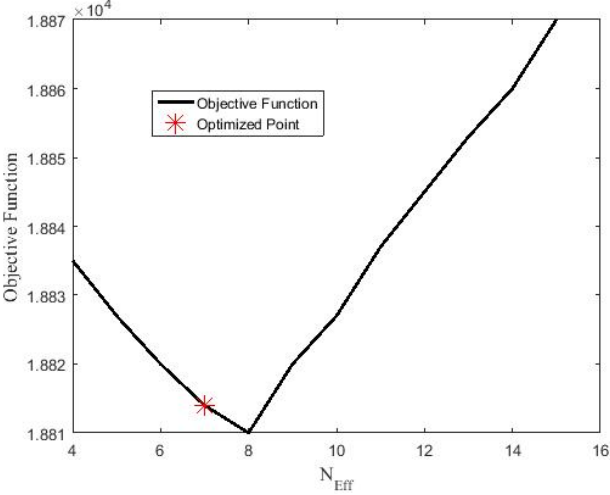
Figure 10. Variations in the objective function with the number of MED effects.